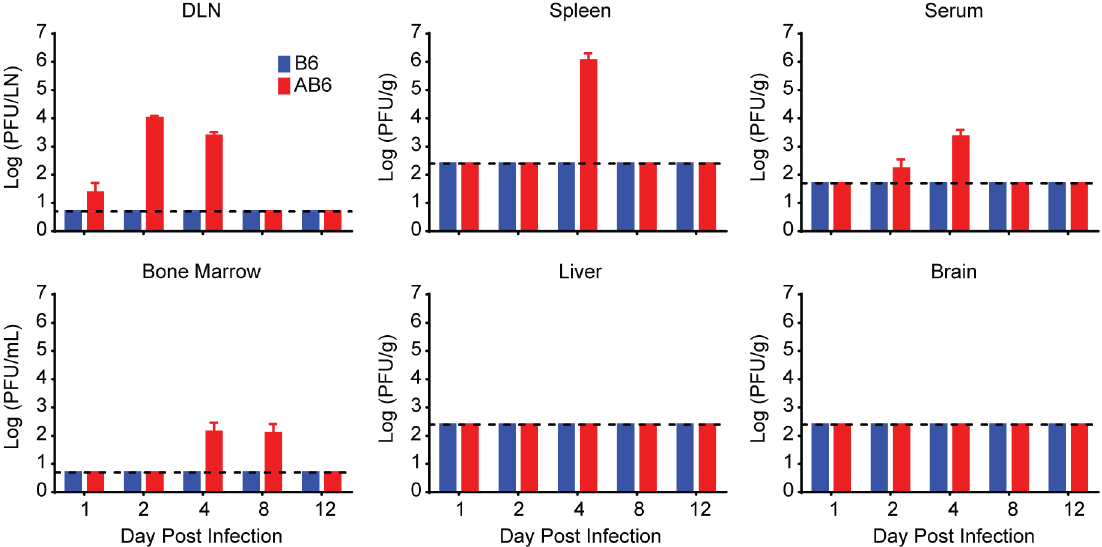
Fig 1. Replication and clearance of 17D-204 in AB6 mice. Five week old B6 or AB6 mice were infected s.c. with 1x10 4 PFU of 17D-204 virus. On the indicated days p.i., mice were euthanized, perfused with virus diluent, and tissues were collected. Tissues were homogenized and a standard plaque assay was performed to determine the titers of 17D-204 in each tissue. The experiment was completed one time (B6, n = 6; AB6, n = 6 –